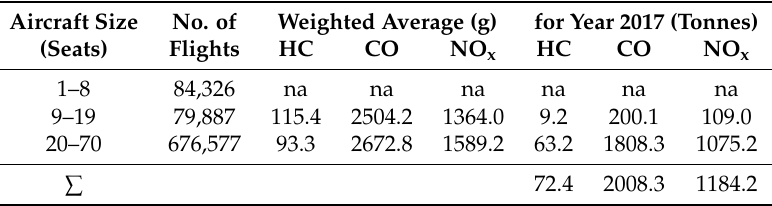
Table 1. Calculation of gas emissions for different aircraft sizes in